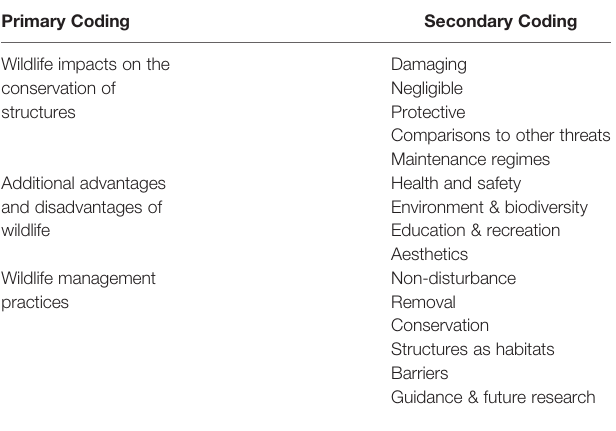
TABLE 2 | List of primary and secondary themes used to code open-ended questionnaire questions and interviews. Primary